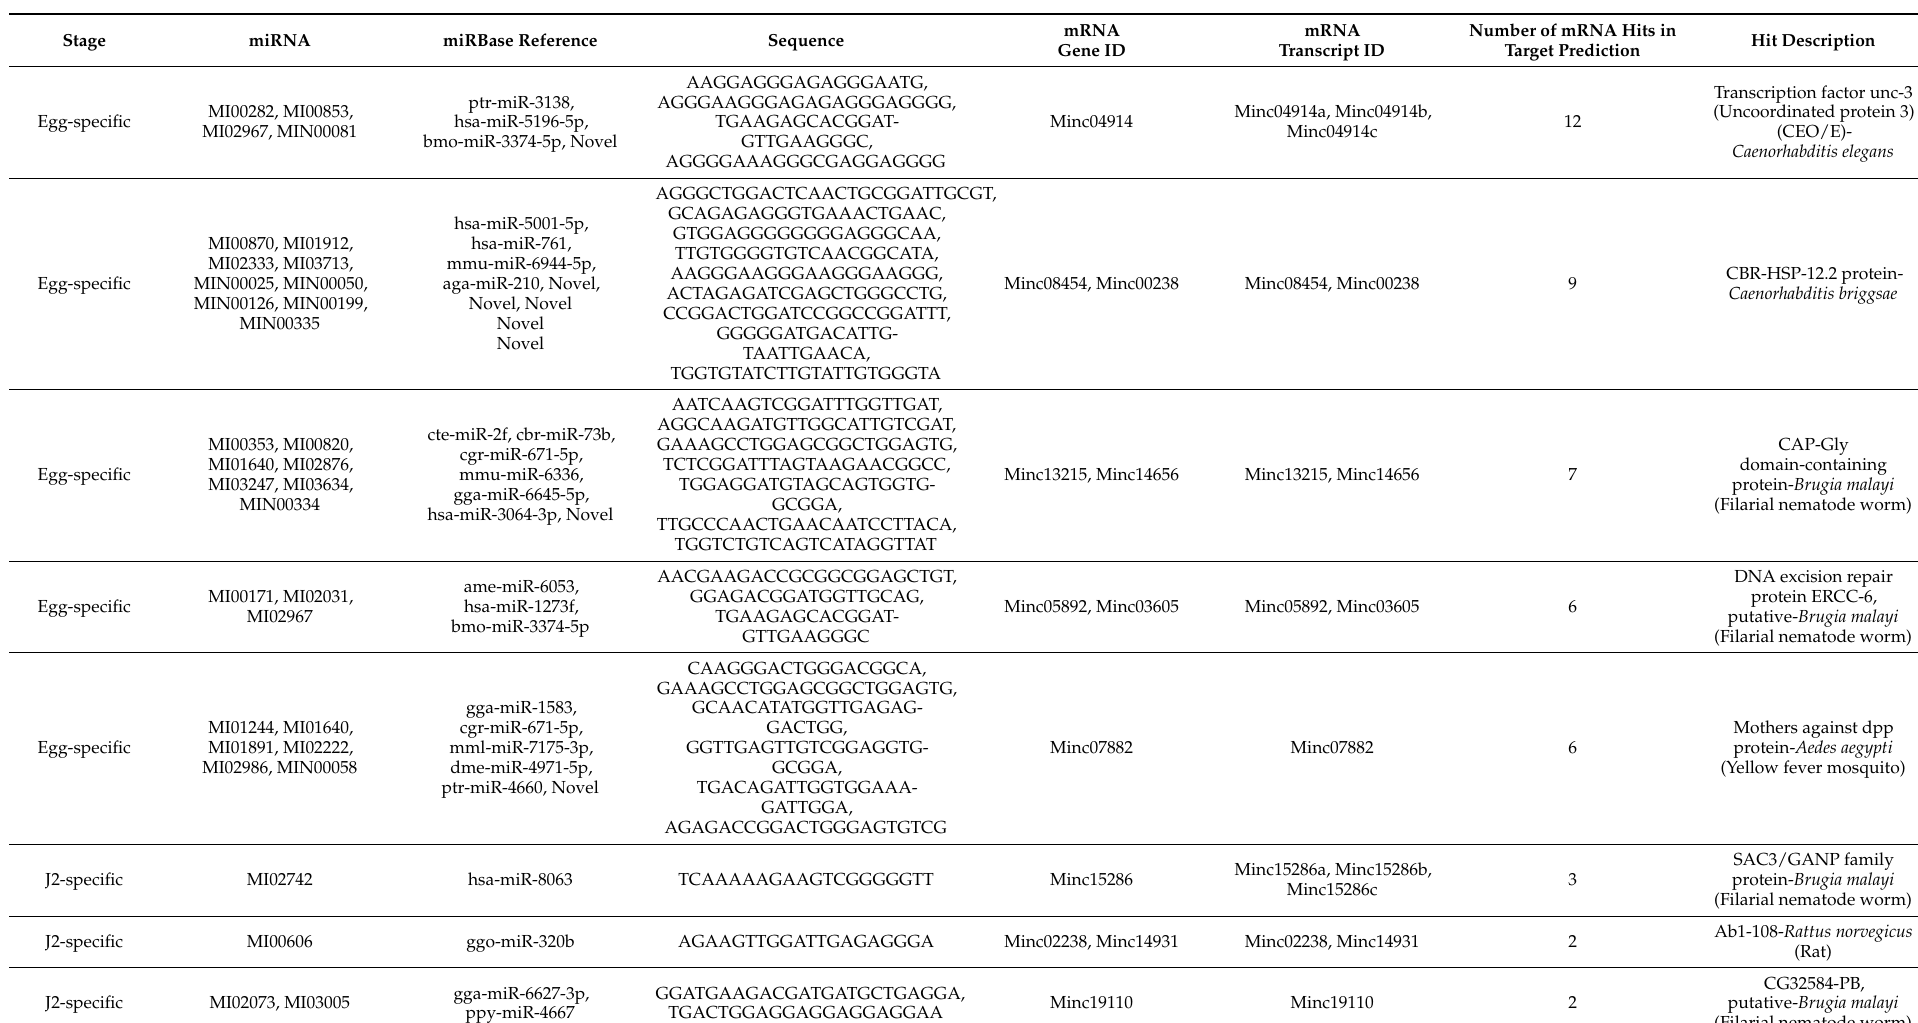
Table 5. Stage-specific targets of miRNA obtained using miRanda, RNAhybrid and PITA. Prediction of miRNA targets was conducted only for miRNA sequences reported in our pervious study [3] with read count >